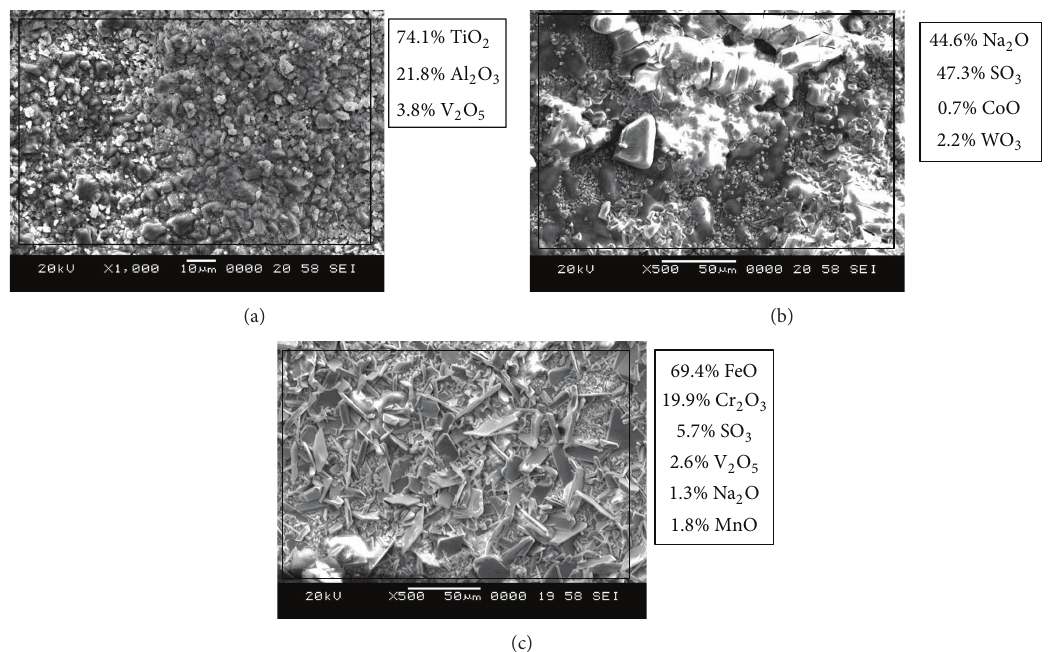
Figure10:MorphologyandEDXanalysisofcorrodedsamples.Micrographscorrespondingto(a),(b),and(c)areforuncoatedTi-31,Superco- 605, and MDN-121 samples, respectively.